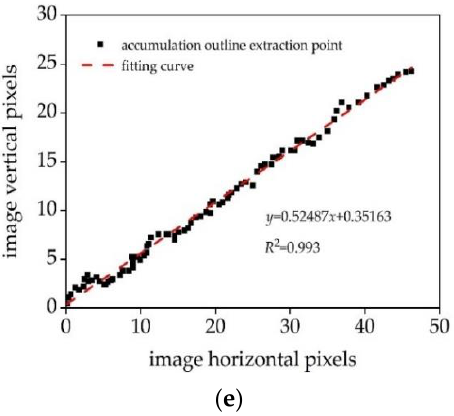
Figure 4. The calculation process of soil stacking angle. ( a ) The original image; ( b ) gray-scale image; ( c ) binarization of the image; ( d ) contour curve image; ( e ) fitting line.